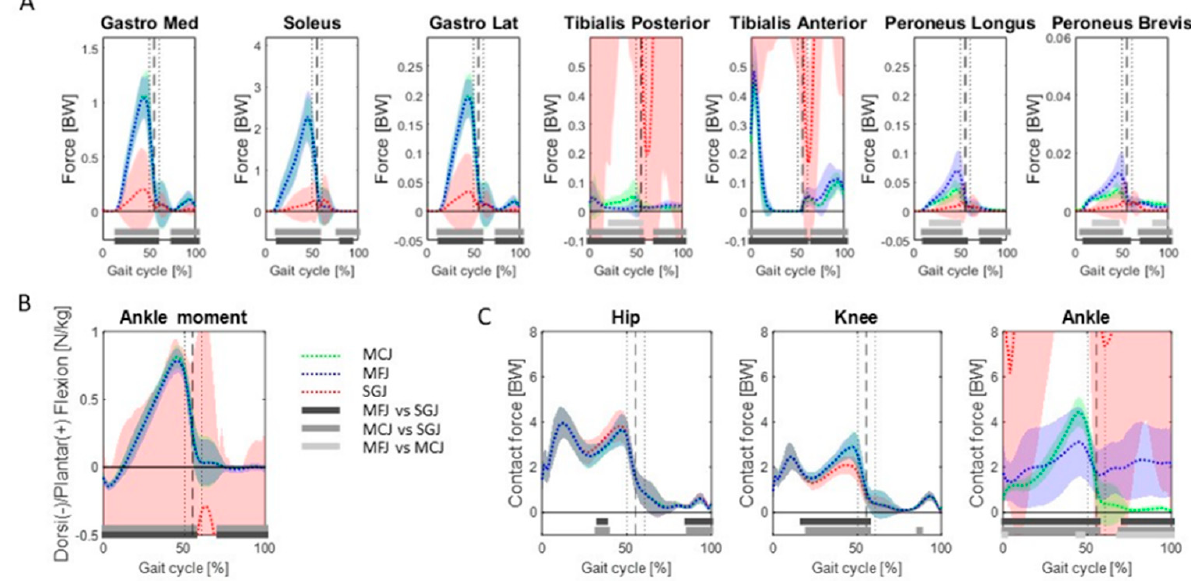
Figure 5. M2 outputs for the average cohort, when different from M1 outputs: forces exerted for significant muscles at the ankle ( A ); ankle joint moment ( B ); joint contact force ( C ). Bottom gray bars represent the region of the gait cycle where post-hoc tests were significant.